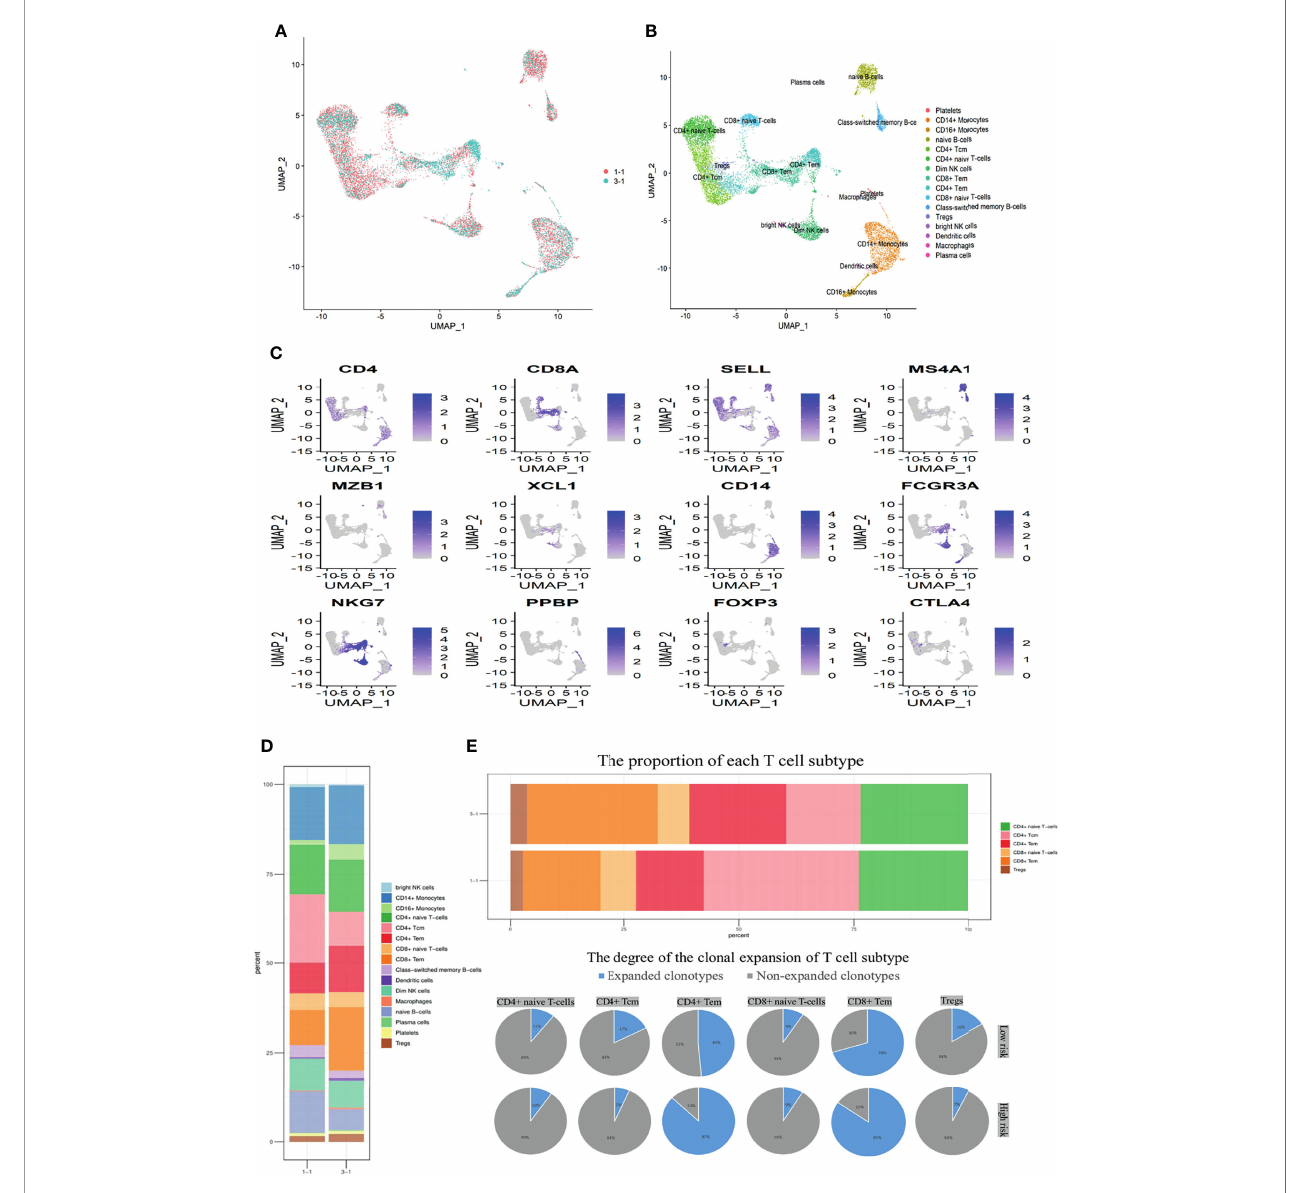
FIGURE 5 | Perturbations of lymphocytes were induced in the “ High-risk ” group determined by scRNA. (A) Perioperative PBMC for “ High-risk ” (3-1) and “ Low-risk ” (1-1) samples from two treatment-naive localized RCC patients with tumor thrombus are shown. Each dot represents a cell. (B) Sixteen clusters were identi fi ed by principal component analysis and visualized with UMAP. (C) UMAP plots show the expression levels of canonical marker genes for 16 cell types. (D) The stack bar plot shows the proportions of all cell subtypes of PBMC. (E) The stack bar plot represents the proportions of all T-cell subtypes of PBMC. The pie chart shows the distribution of TCRB clonotypes in different T-cell subtypes. Expanded clonotype was de fi ned as which is detected more than